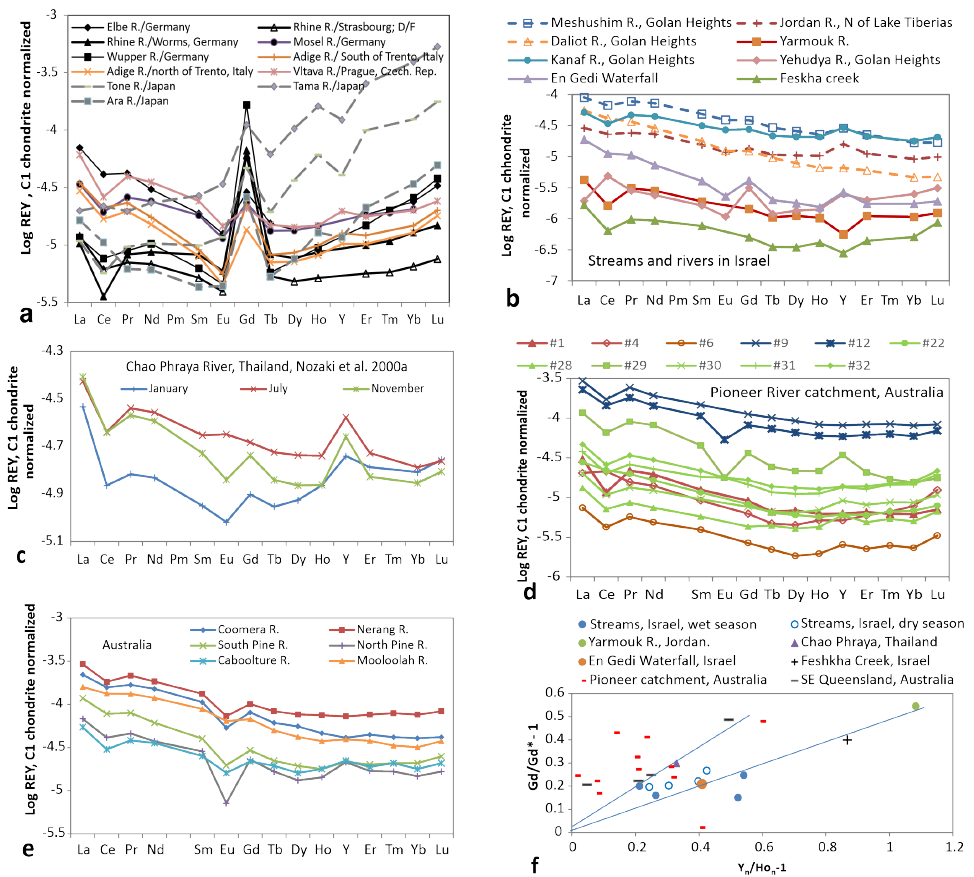
Figure 6. REY in rivers and streams. ( a ) Examples of rivers contaminated by anthropogenic Gd [48,49,52]; ( b ) Stream and rivers in Israel during wet (broken) and dry (bold) seasons; ( c ) Chao Phraya River in Thailand during three different seasons [64]; ( d ) Streams from various siliceous rocks and Quaternary sediments in Australia [56]. Note that Eu is often not reported; ( e ) Rivers in South East Queensland, Australia [57]; ( f ) Correlation of Gd and Y anomalies. Upper and lower tentative trends are given with slopes of about 1 and 0.5,